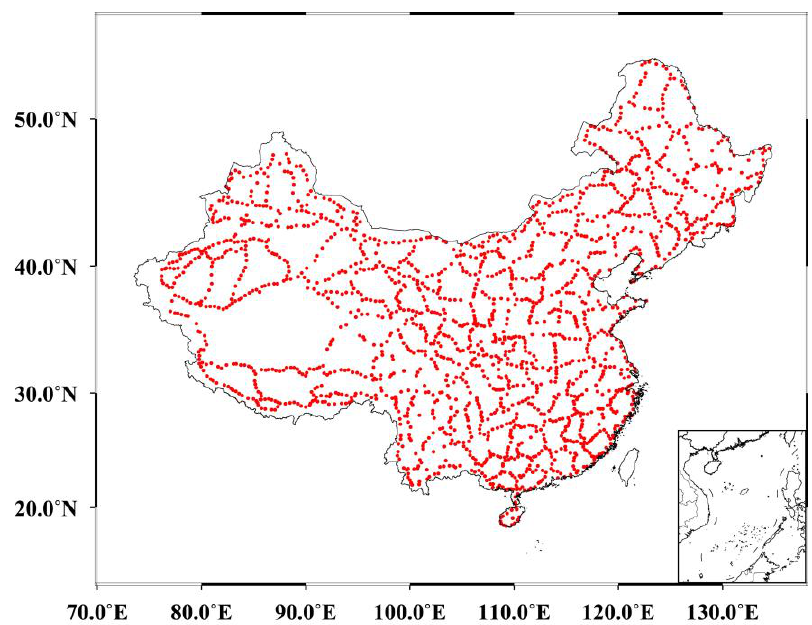
Figure 1. Distribution of GNSS/leveling benchmarks.